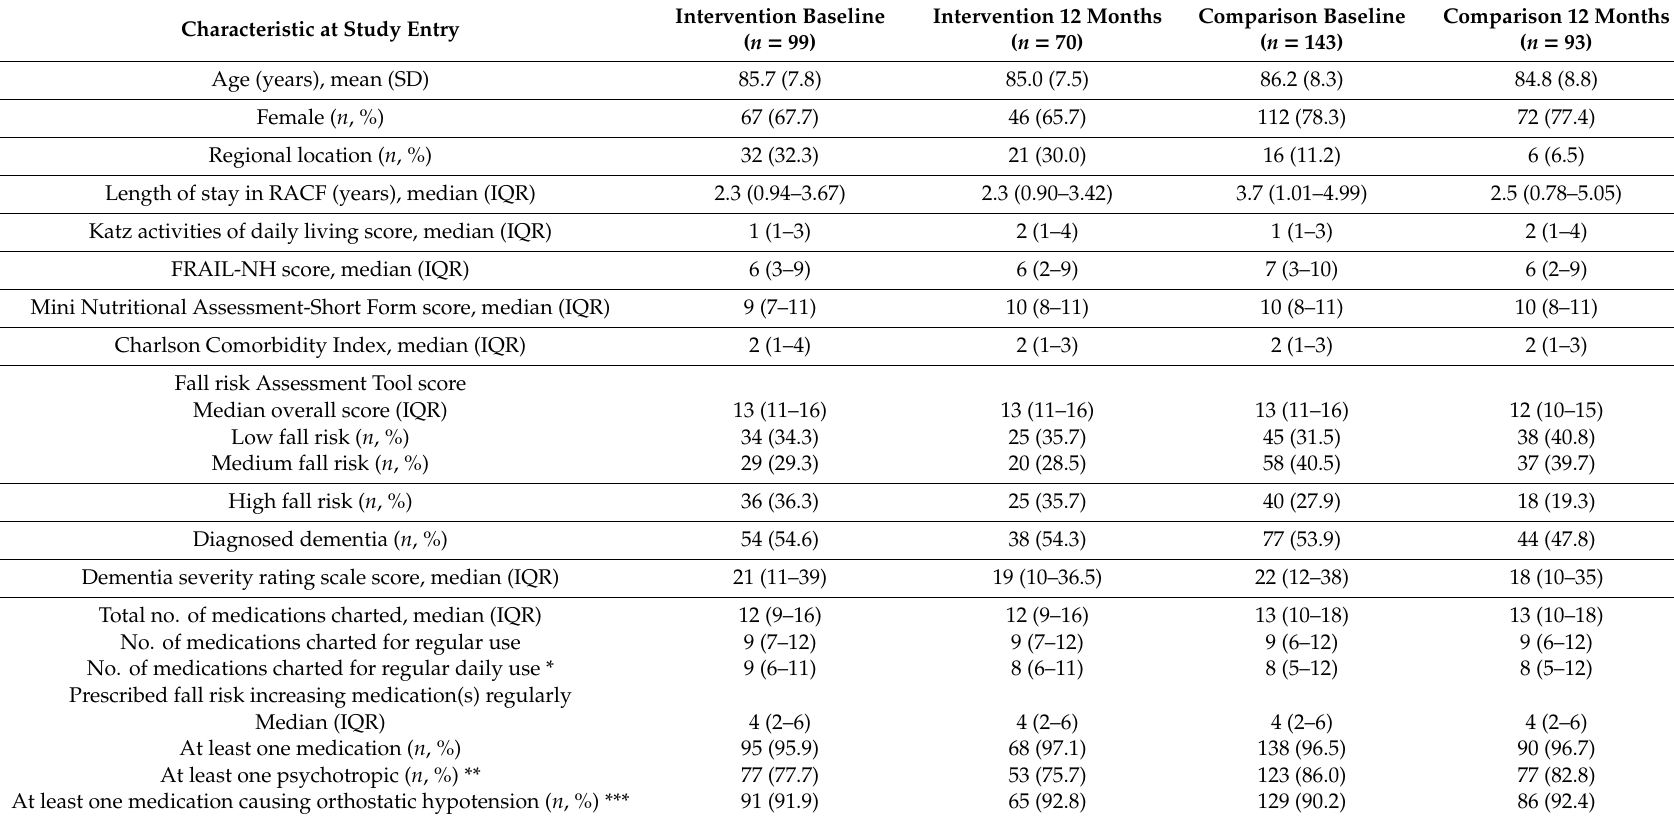
Table 1. Baseline characteristics of participating residents at study entry and at 12 month follow